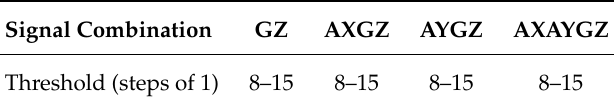
Table 2. Probabilistic DTW (pDTW)